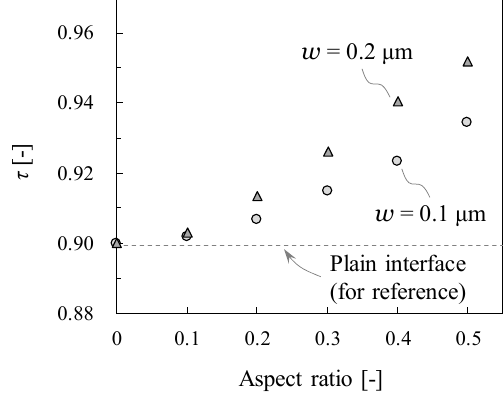
Figure 5. Simulated transmission coefficient as a function of aspect ratio (circles: w = 0.1 μ m, and triangles: w = 0.2 μ m). A value corresponding to the transmission coefficient of a plain interface is indicated by the horizontal dashed line for reference.